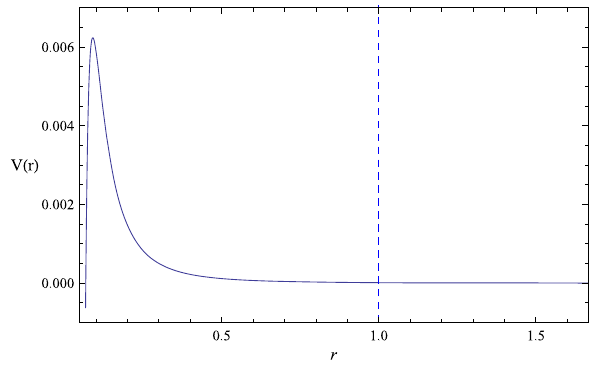
Fig. 2 We plot V ( r ) as a function of the radial coordinate r with q = 100, m 2 = 0, Q = 0 . 001 and M = 2. The vertical dashed blue line r b = 1 corresponds to the box boundary and the horizon is around r h ≈ 0 . 06667. Here, we have used the scaling symmetry r → α r to set r b = 1 with α = 1